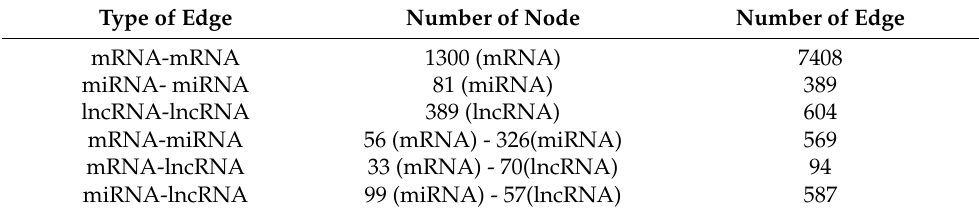
Table 4. Edge Information in Heterogeneous